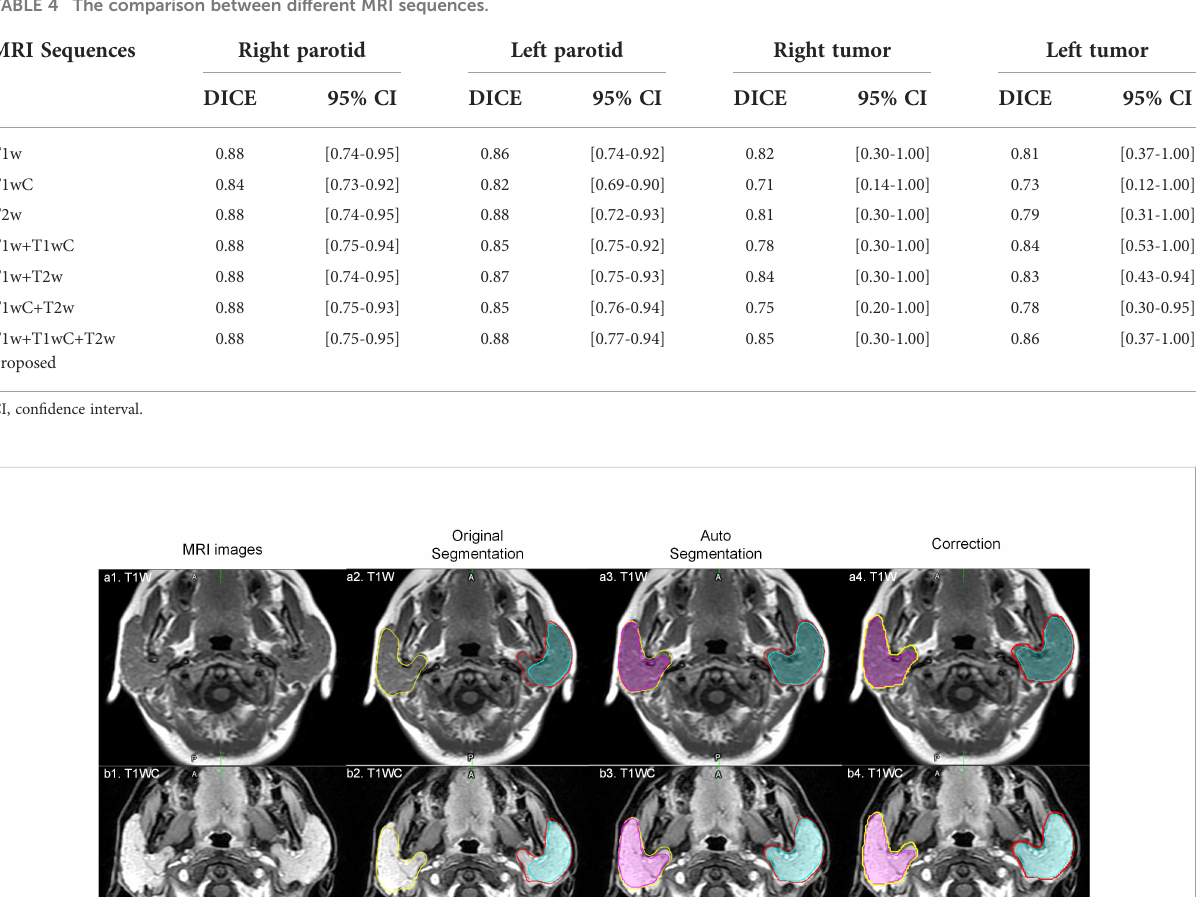
TABLE 4 The comparison between different MRI sequences.